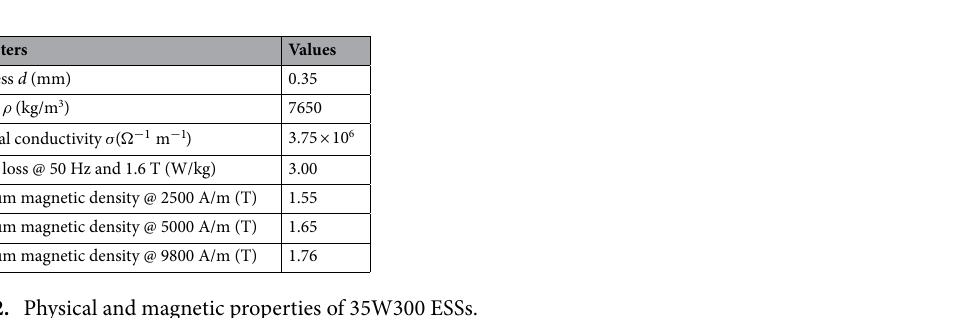
Table 2. Physical and magnetic properties of 35W300